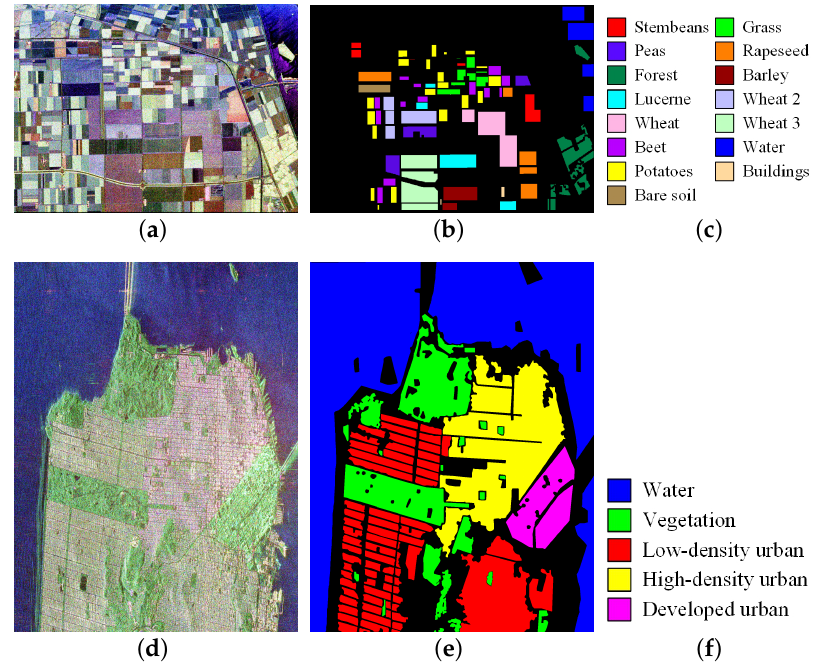
Figure 3. AIRSAR Flevoland and RS-2 San Francisco datasets. ( a ) Pauli pseudo-color image of Flevoland. ( b ) Ground truth of Flevoland. ( c ) Labels of Flevoland. ( d ) Pauli pseudo-color image of San Francisco. ( e ) Ground truth of San Francisco. ( f ) Labels of San